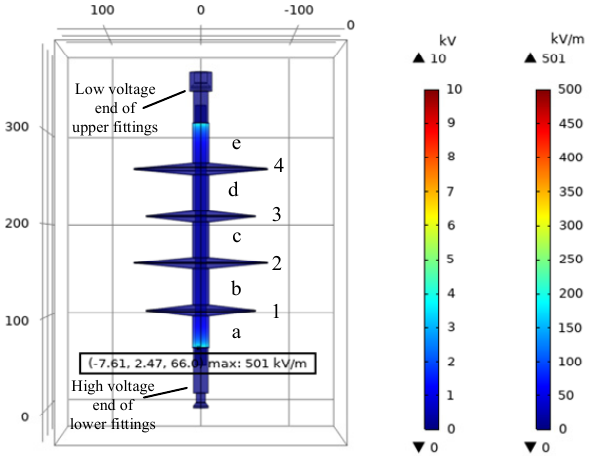
Figure 8. Electric field potential distribution of the composite insulators covered with the NaCl fouling.